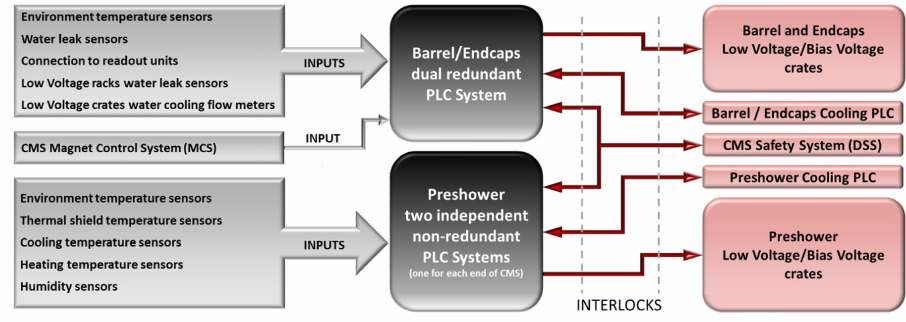
Figure 1. The CMS ECAL DCS in numbers.